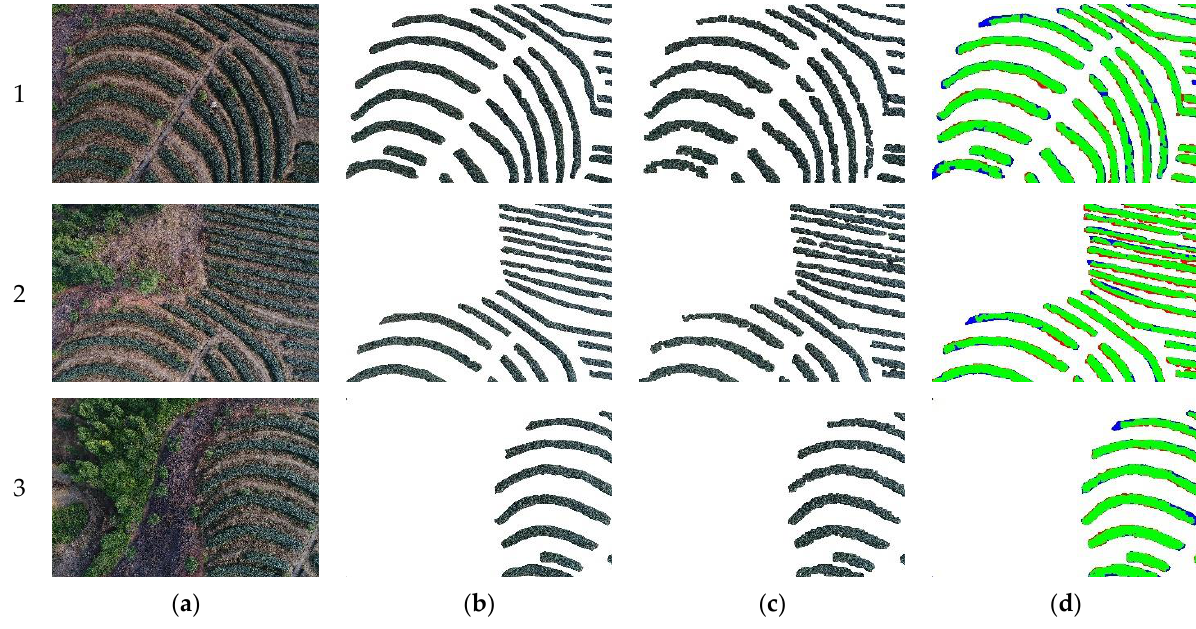
Figure 15. Comparison images of the ground truth and method in this study. ( a ) Raw image; ( b ) tea tree extracted by humans; ( c ) tea tree extracted in this study; and ( d ) result of the contrast between ( b , c ).